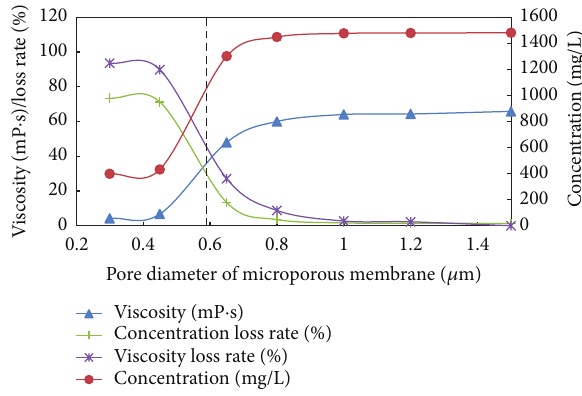
Figure 2: Concentration and viscosity of polymer and their loss rate with different diameters of microporous membrane.